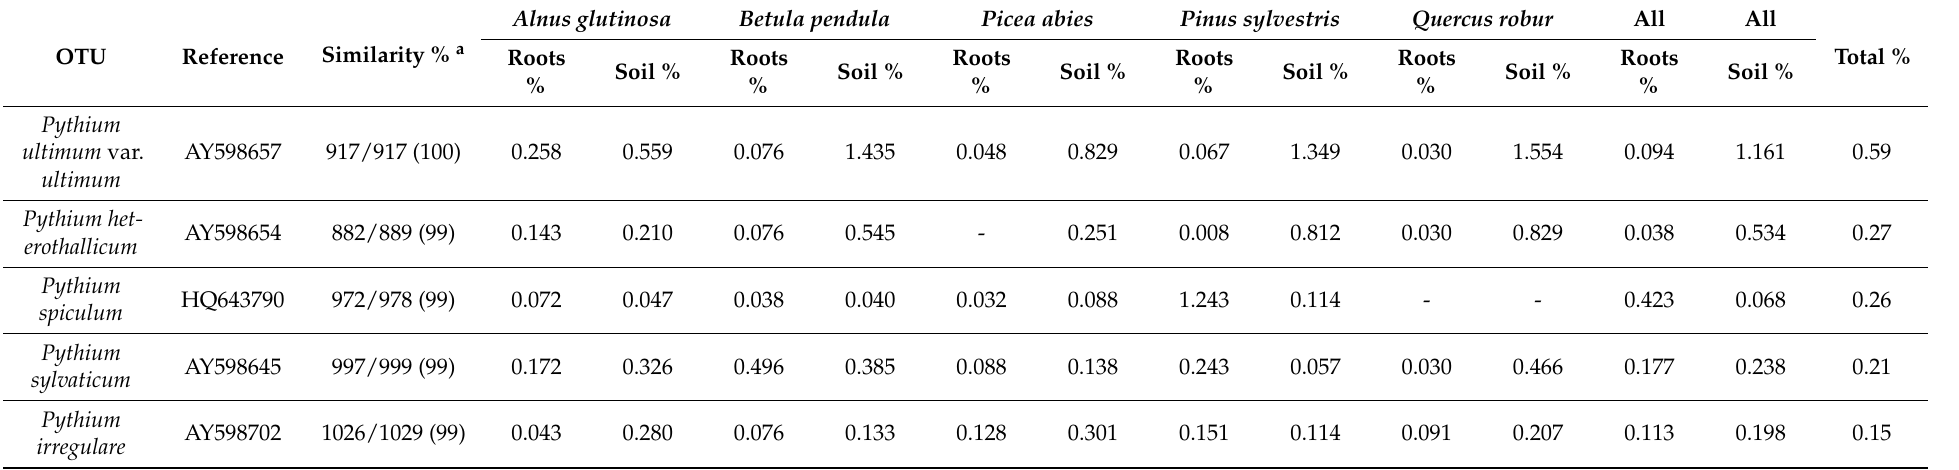
Table 4. Occurrence and relative abundance of the 30 most common oomycete OTUs (shown as a proportion of all of the high-quality fungal sequences) in the roots and soil of the five tree species that were bare-root cultivated in the forest nurseries. The data from the different forest nurseries are